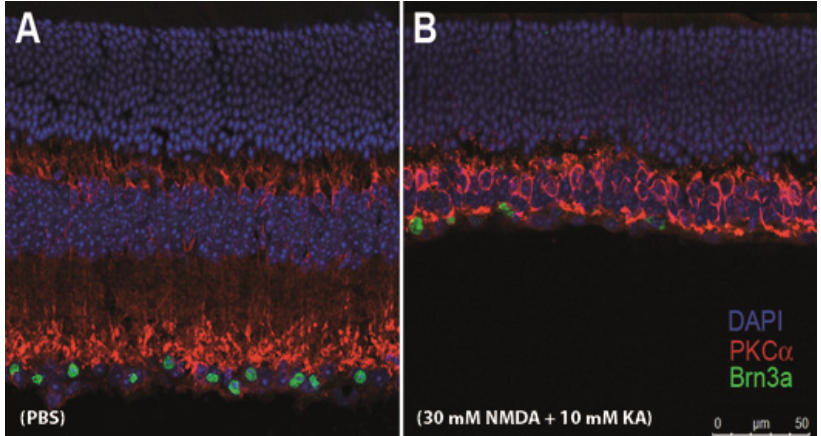
Figure 5 . Cross retinal sections in a mouse eye after intraocular injection of NMDA and Kainate. ( A ) Left eye; control eye injected with PBS. ( B ) Right eye injected with 30 mM NMDA and 10 mM KA. Cells were labeled with DAPI (nuclear marker), PKC α (rod bipolar cell marker) and Brn3a (ganglion cell marker) seven days after intraocular injection.